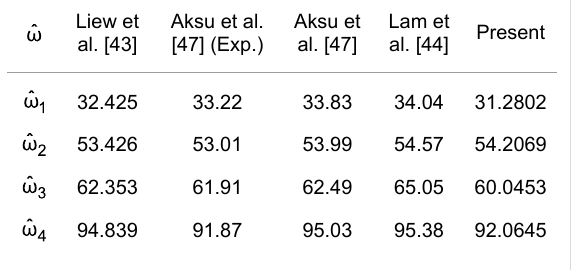
Table 6: First four frequency parameters, , for a CSCS, rectangular, isotropic, homogeneous plate with a rectangular cutout with ν = 0.3, c/a = d/b = 1/3 , a/b = 9/8 and a/h = 100. Liew et al.